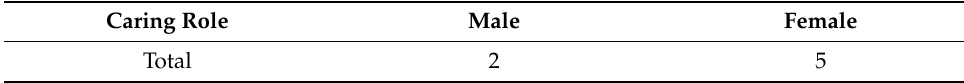
Table 4. Participants with a caring role outside